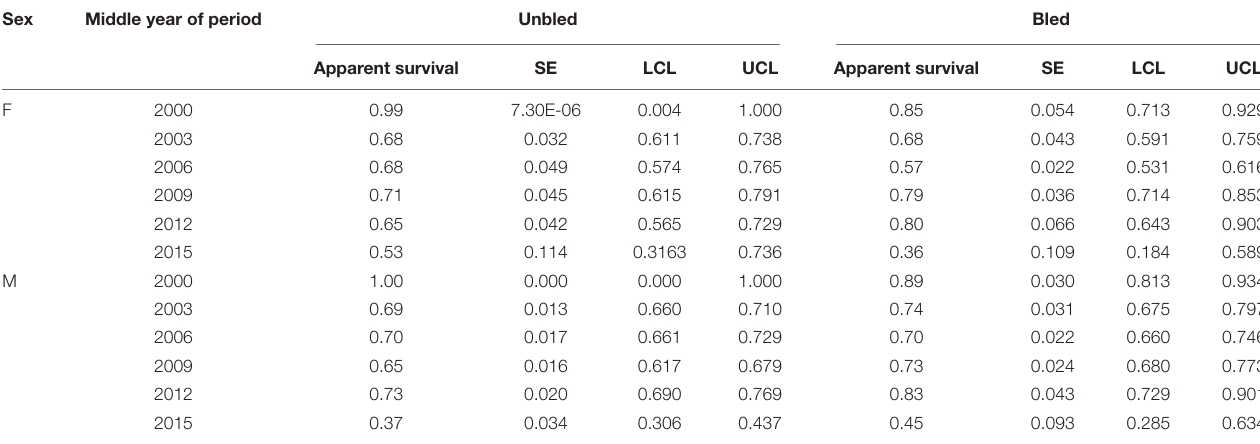
TABLE 4 | Estimates of apparent survival, standard error (SE), and 95% confidence limits (LCL, UCL) for the top model for tagged horseshoe crabs released in Delaware Bay population (Delaware Bay and coastal Delaware to Virginia regions, cf Table 3 and Figure 1 ) from 1999 to 2017. Sex Middle year of period Unbled Bled Apparent survival SE LCL UCL Apparent survival